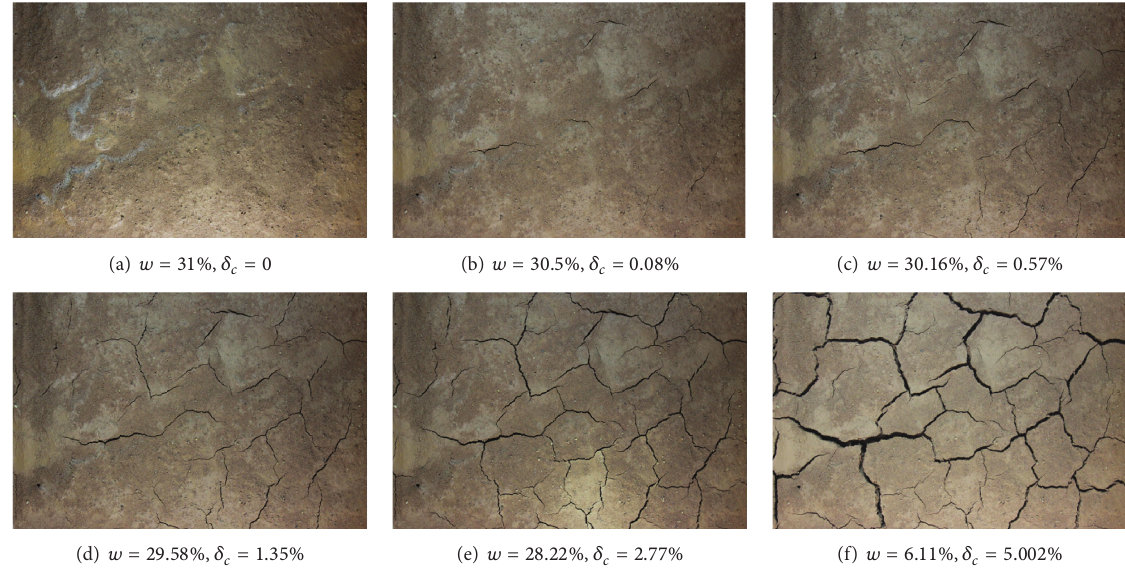
Figure 3: Crack development during a drying process.